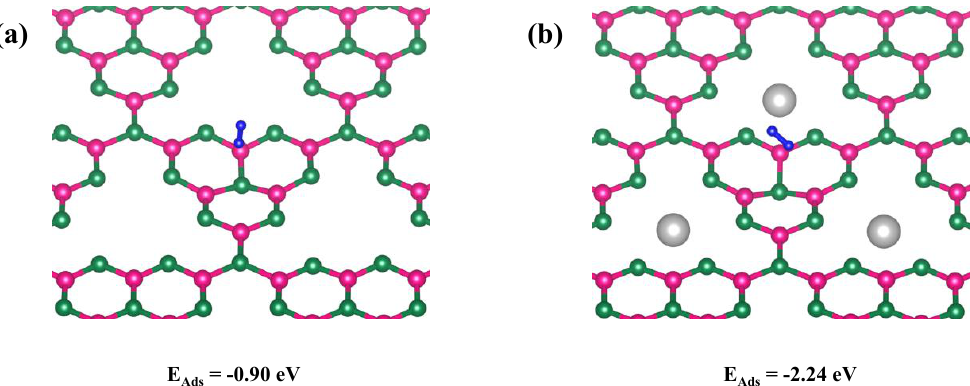
Figure 13. ( a ) The optimized configuration of the pristine g-C in the vicinity of N atom; ( b ) the optimized configuration of the Al − decorated g-C adsorbed H molecule in the vicinity of N atom. The adsorption energies were presented for these 2 two configurations.